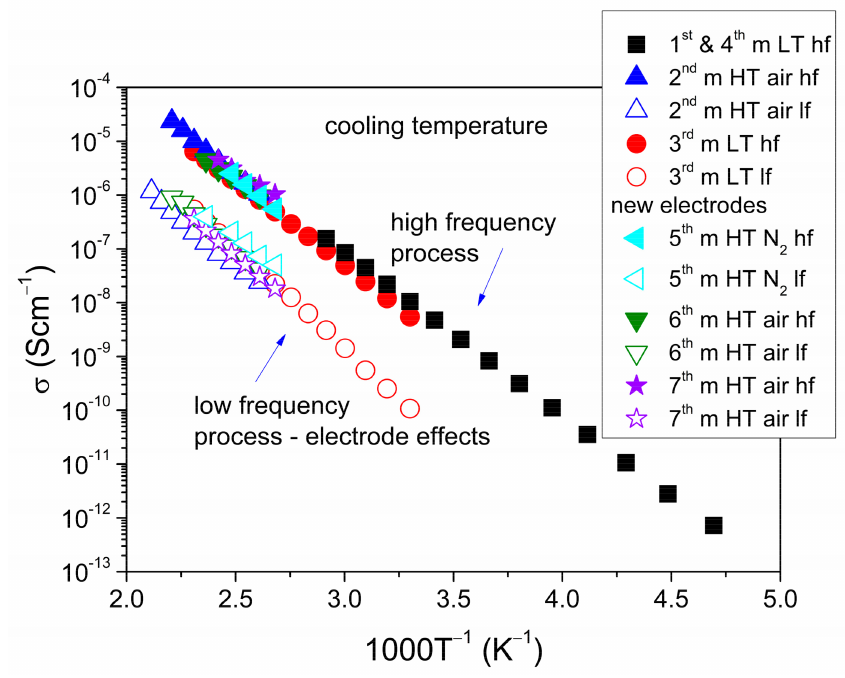
Figure 4. The conductivity versus reciprocal temperature for the relaxation processes was estimated from Figure 3. Table 3. The activation energy values for the relaxation processes observed in the Nyquist plots and estimated from Figure 4 and relation